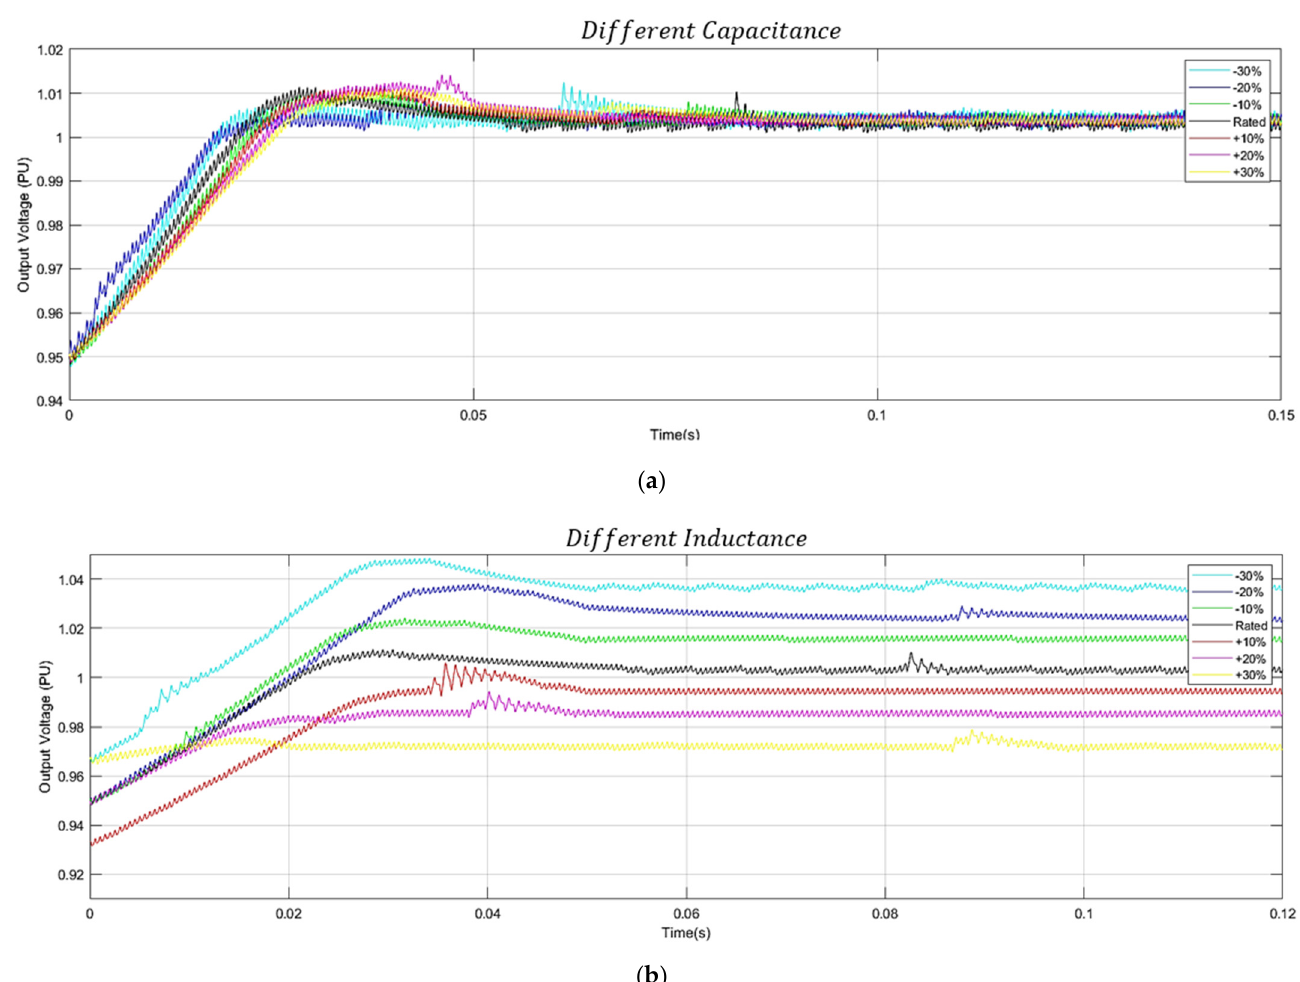
Figure 16. Behavior output voltage to step (550 to 600 V) for different parameters with P out = 5.5 kW ( a ) capacitance, ( b ) inductance.